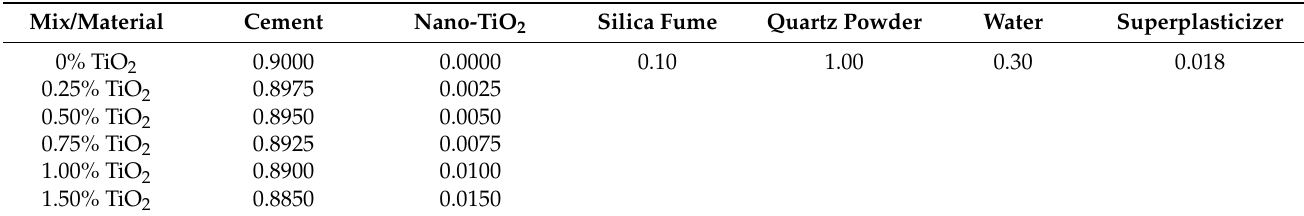
Table 2. Detailed composition of the mortars produced (by